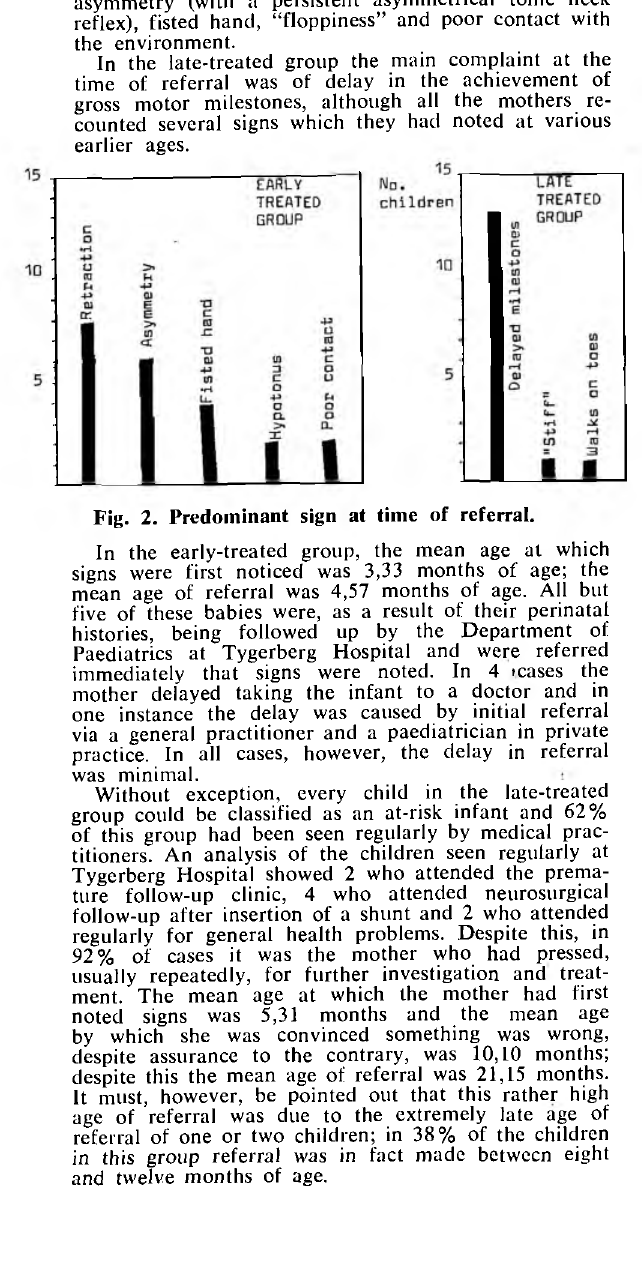
Fig. 3. Referral of late-treated group.